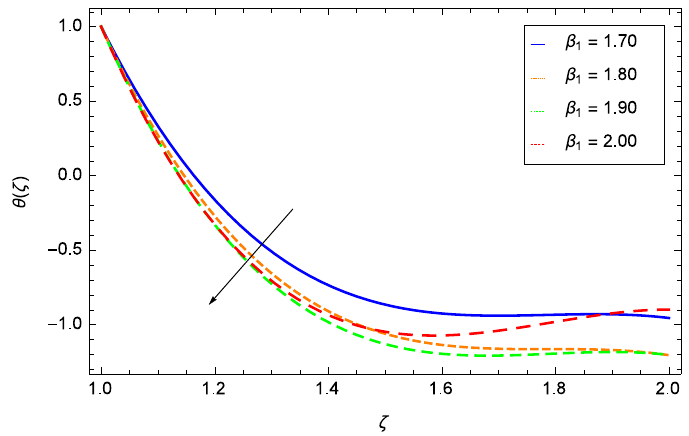
Figure 8. Non-dimensional temperature θ ( ζ ) sketch for h = − 0.10, M = 2.00, Re = 5.00, φ = 0.04, Pr = 6.80 and various values of β 1 (CuO-H 2